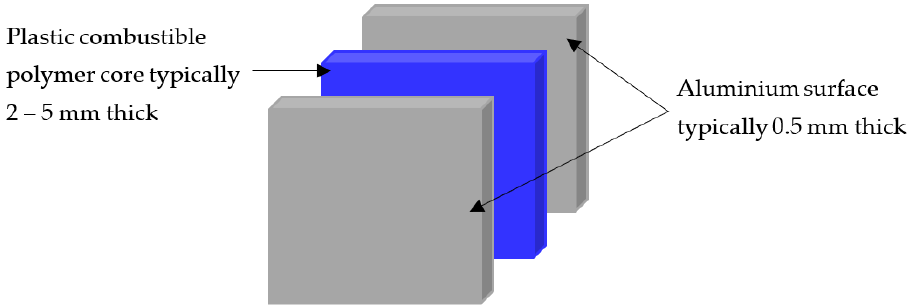
Figure 1. Basic structure of combustible cladding.